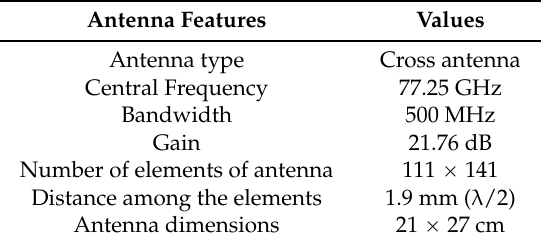
Table 1. Antenna